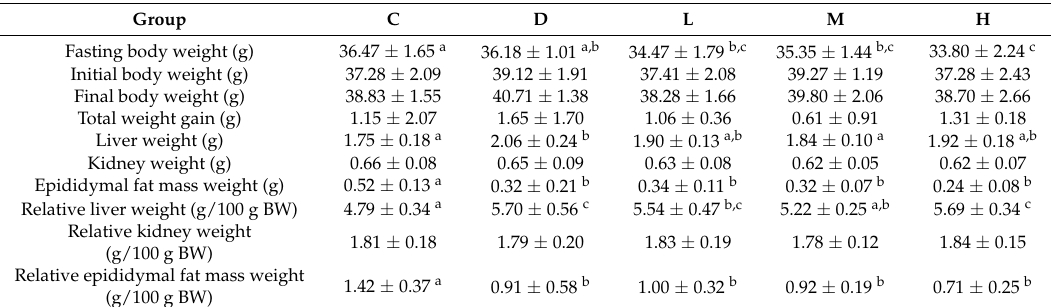
Table 1. Body, fat mass, and organ weights after the six-week melatonin intervention.